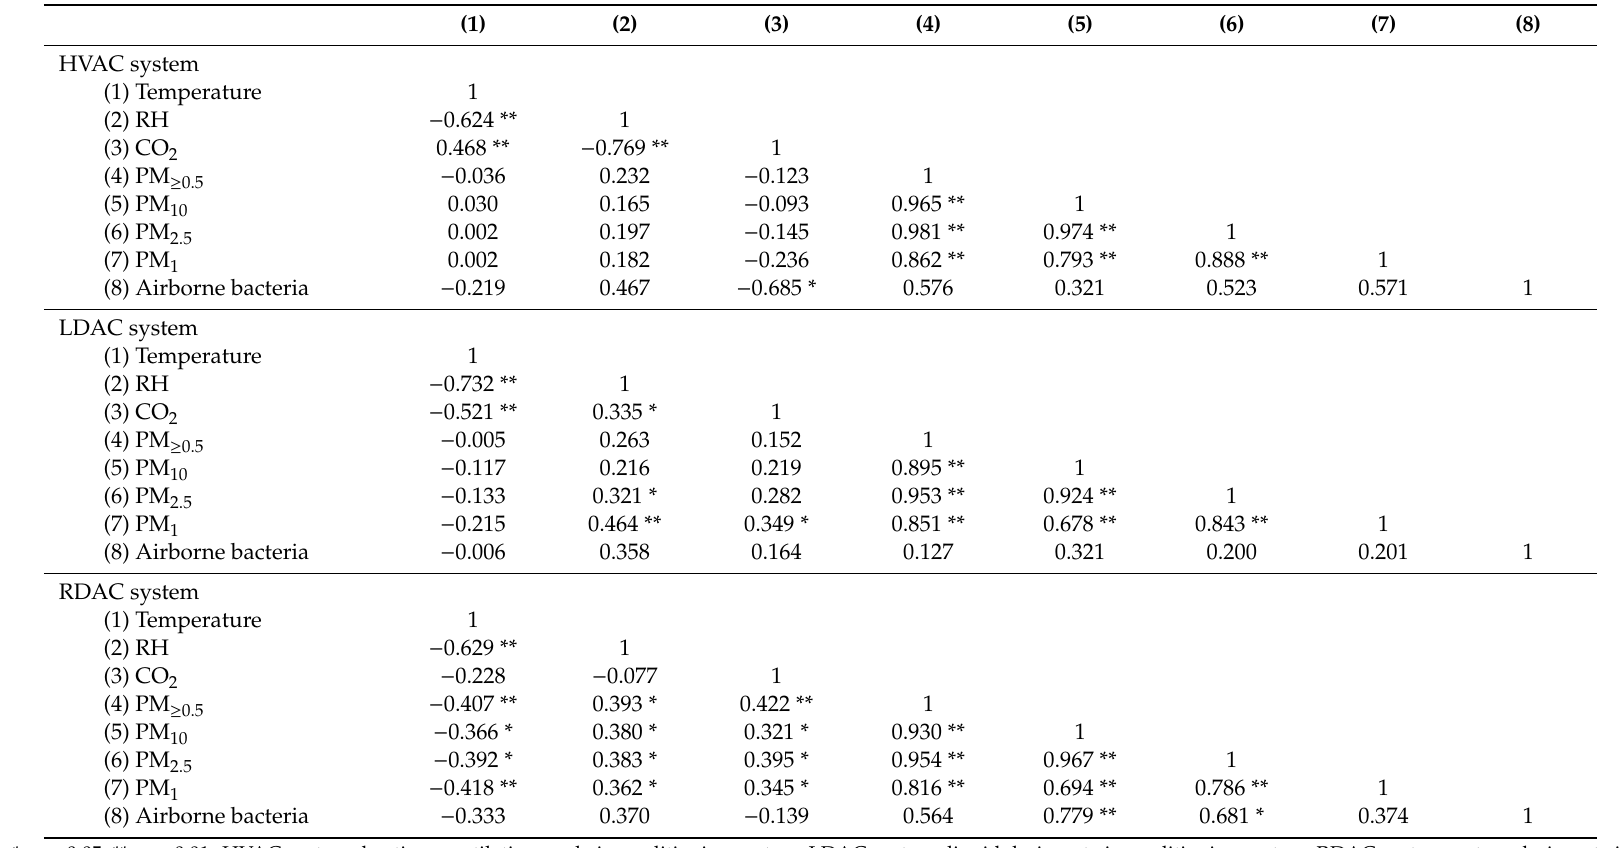
Table 2. Associations of indoor thermal–hygrometric conditions and air quality indices in the ORs with di ff erent dehumidification air conditioning